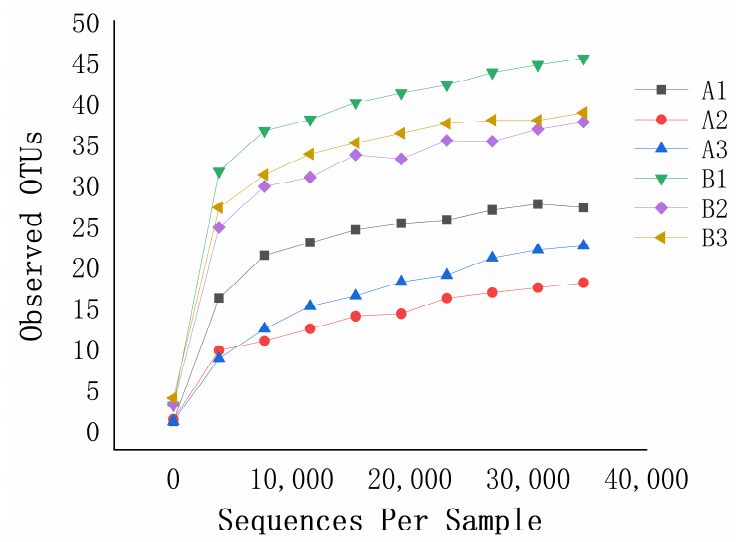
Figure 4. Rarefaction curves for the sunflower seed kernels. A1–A3, unmildewed (2018–2020); B1– B3, mildewed (2018–2020).